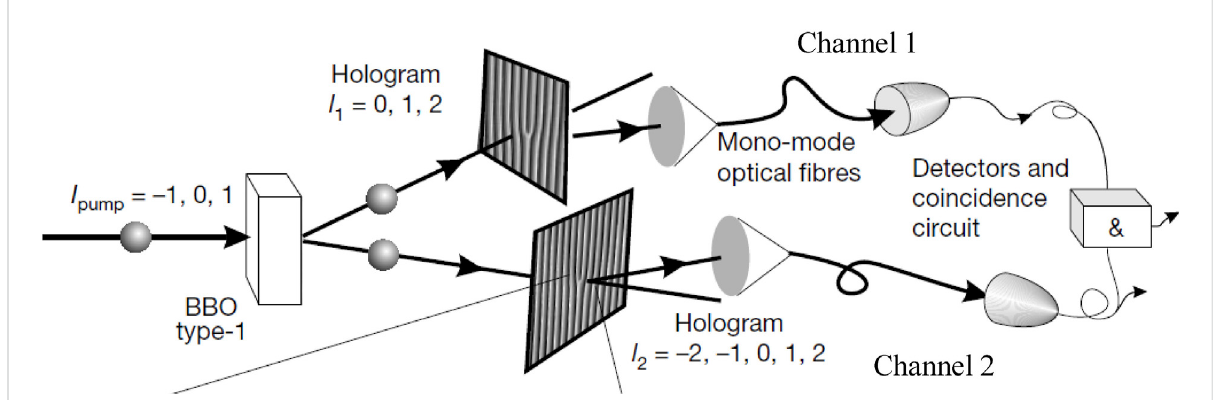
FIGURE 5 Experimental scheme for detection of multidimensional entangled states of photons obtained in the SPS process [79].